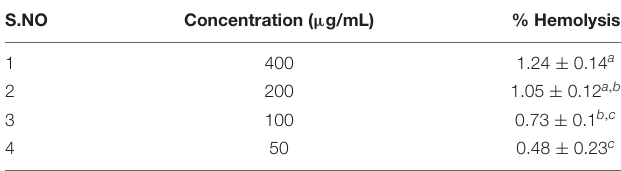
cause and induce genetic abnormalities, leading to tumorigenesis.